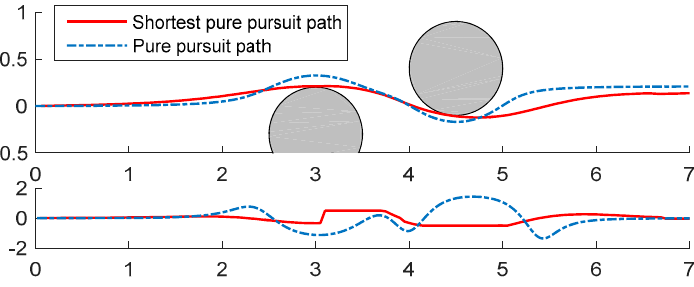
Figure 16. The two obstacle environment. Comparison of the pure pursuit path and weighting streamline path.